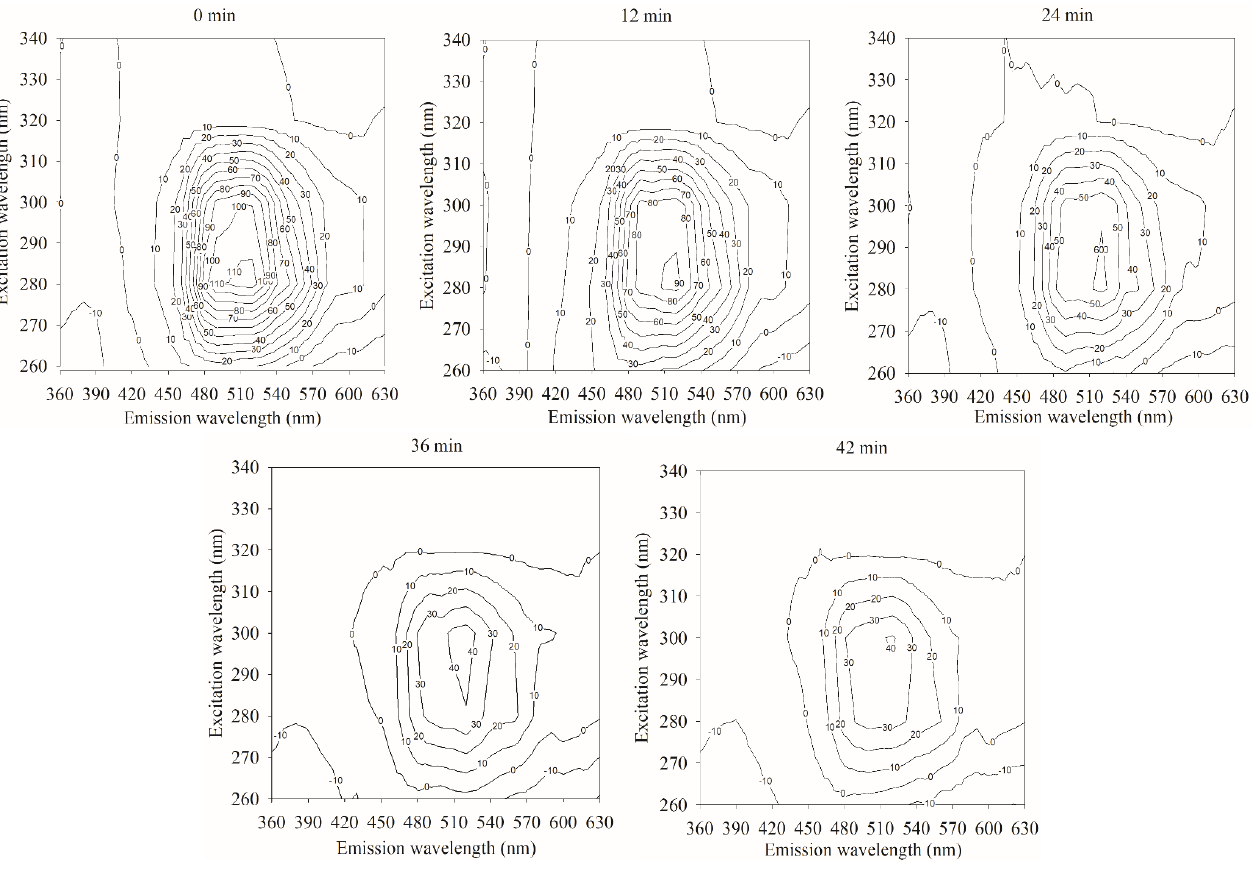
Figure 2. The kinetic evolution contour plots of excitation–emission matrix phosphorescence for calibration sample C4 at specific times (0, 12, 24, 36, and 42 min).